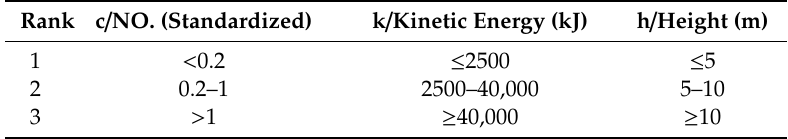
Table 3. The parameter reclassification criteria of rockfall hazard assessment (Modified from Crosta et al. [18]).